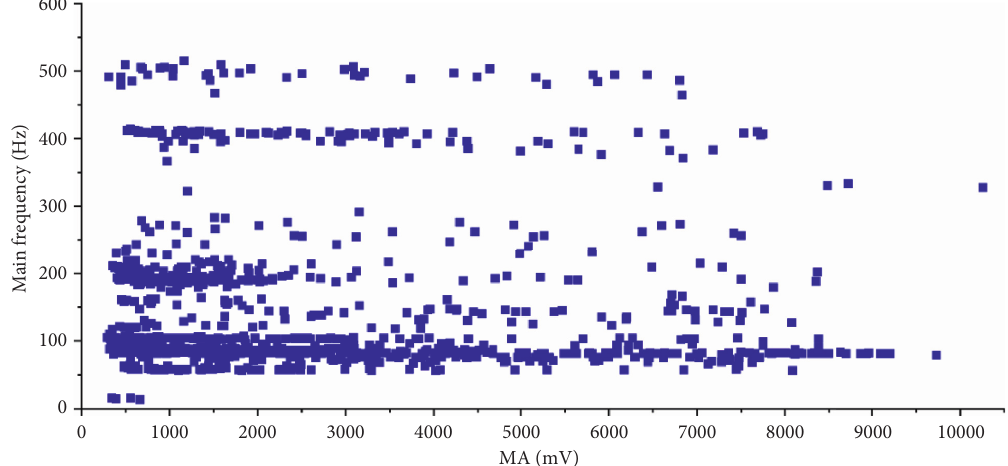
Figure 6: Statistical results of MA and main